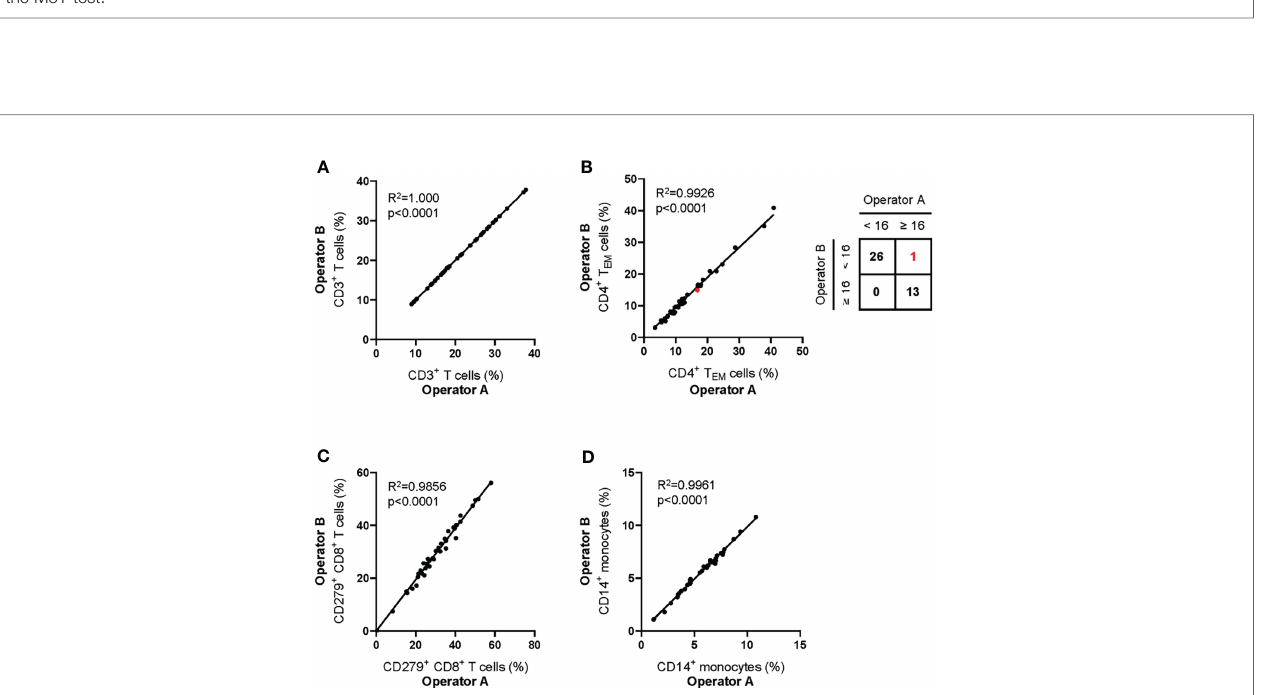
FIGURE 4 | Inter-operator analytical precision of the MoT test. Fresh whole blood EDTA samples from n = 20 healthy donors and n=20 melanoma patients (stage II: n = 7; stage III: n = 3; stage IV: n = 10) were processed using the MoT test. Flow cytometry data were analyzed by two experienced operators according to the gating strategy shown in Figure 2 . Frequencies of CD3 + T cells (A) , CD4 + T EM cells (B) , CD279 + CD8 + T cells (C) and CD14 + monocytes (D) were determined. One sample of borderline CD4 + T EM cell frequency was differently classi fi ed by the two operators (marked in red; inter-operator concordance of 98%).